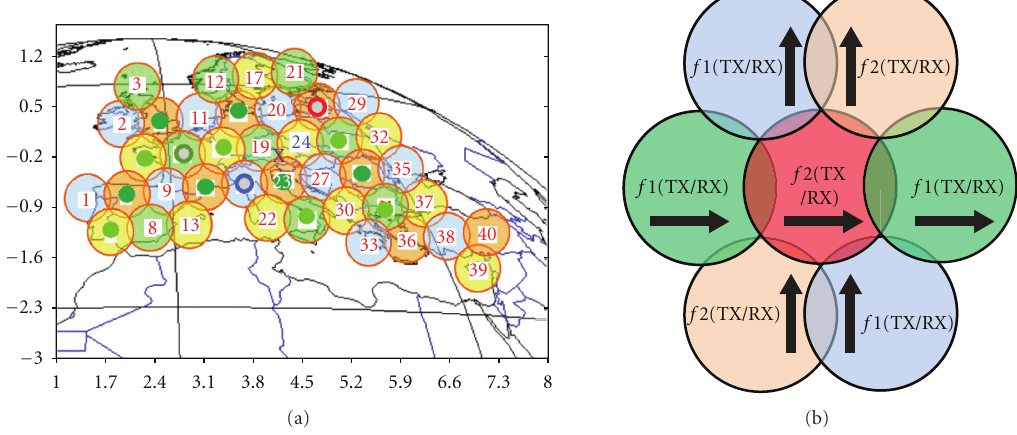
Figure 1: European multibeam coverage with 4x reuse scheme.